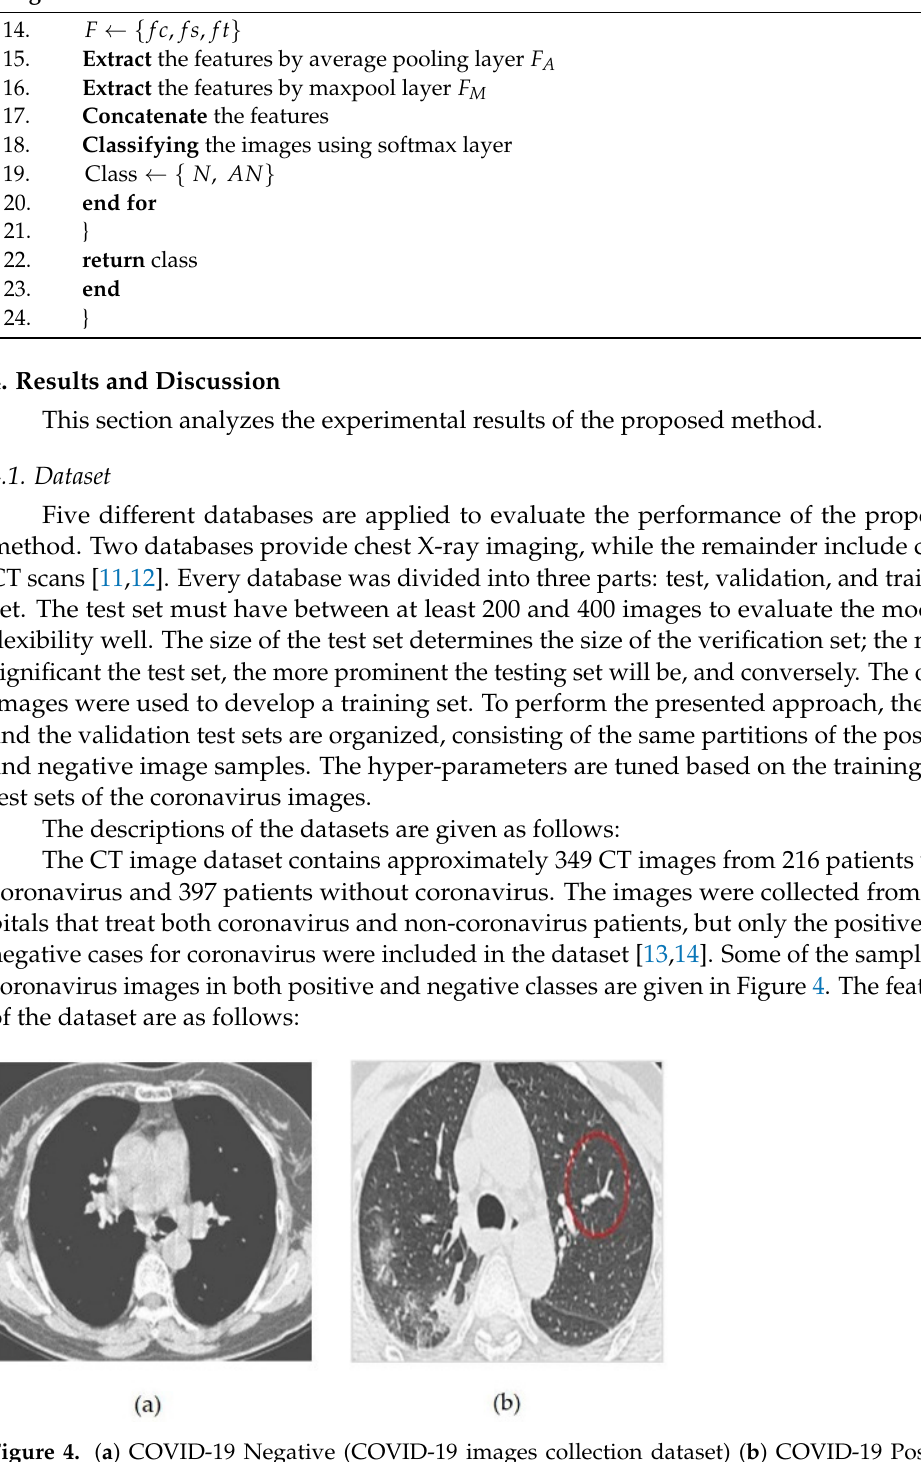
Figure 4. ( a ) COVID-19 Negative (COVID-19 images collection dataset) ( b ) COVID-19 Positive (COVID-19 images collection dataset) .